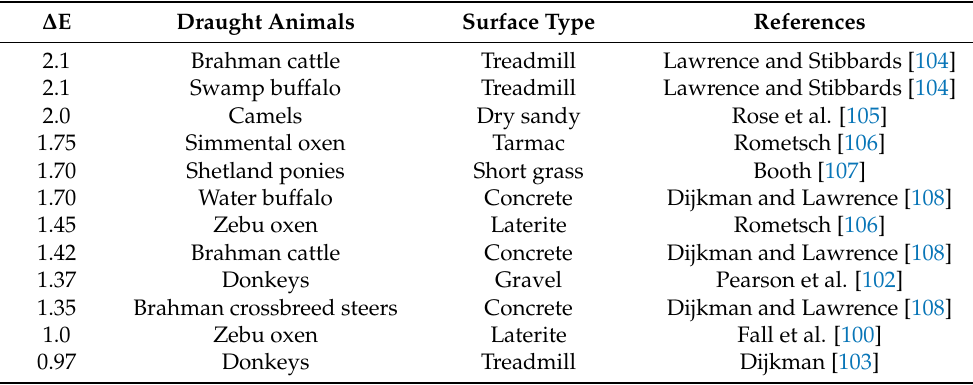
Table 2. Published values of extra energy cost ( ∆ E, J/m per kg of body weight) above standing metabolic rate (J/kg of body weight) for draught animals walking on a dry and flat surface. ∆ E Draught Animals Surface